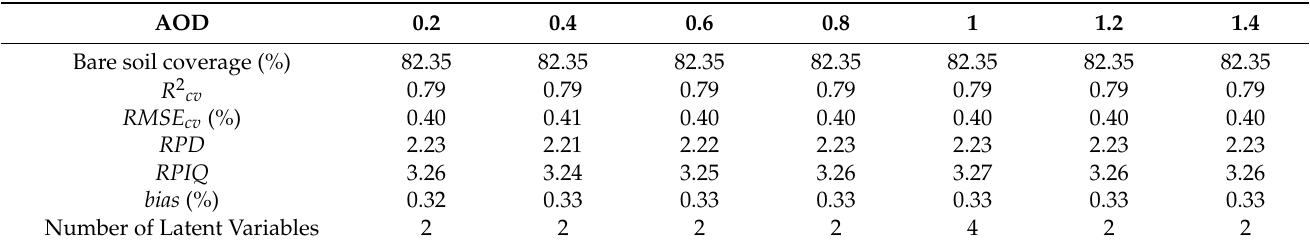
Table 4. Figures of merit obtained from PLSR models, based on Hyperion data corrected by the FLAASH method, and depending on 7 values of AOD.